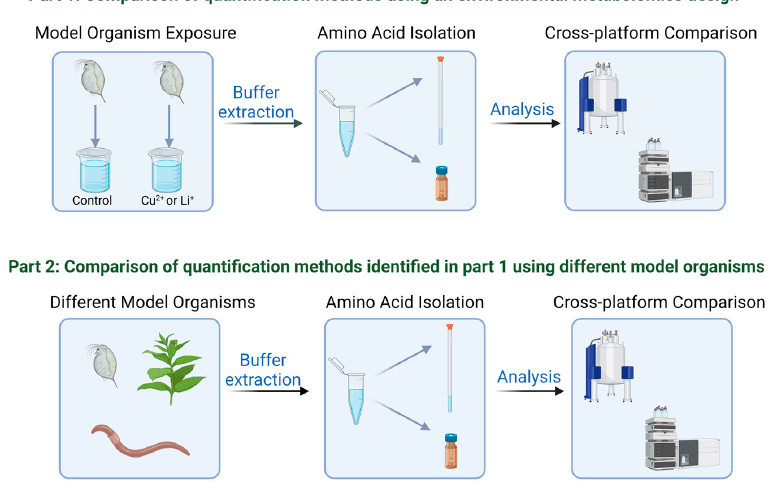
Figure 1. Schematic outlining the two part approach used in this study to compare amino acid quantification methods using nuclear magnet resonance (NMR) spectroscopy and liquid chromatography with tandem mass spectrometry (LC ‐ MS/MS). Created with www.biorender.com.